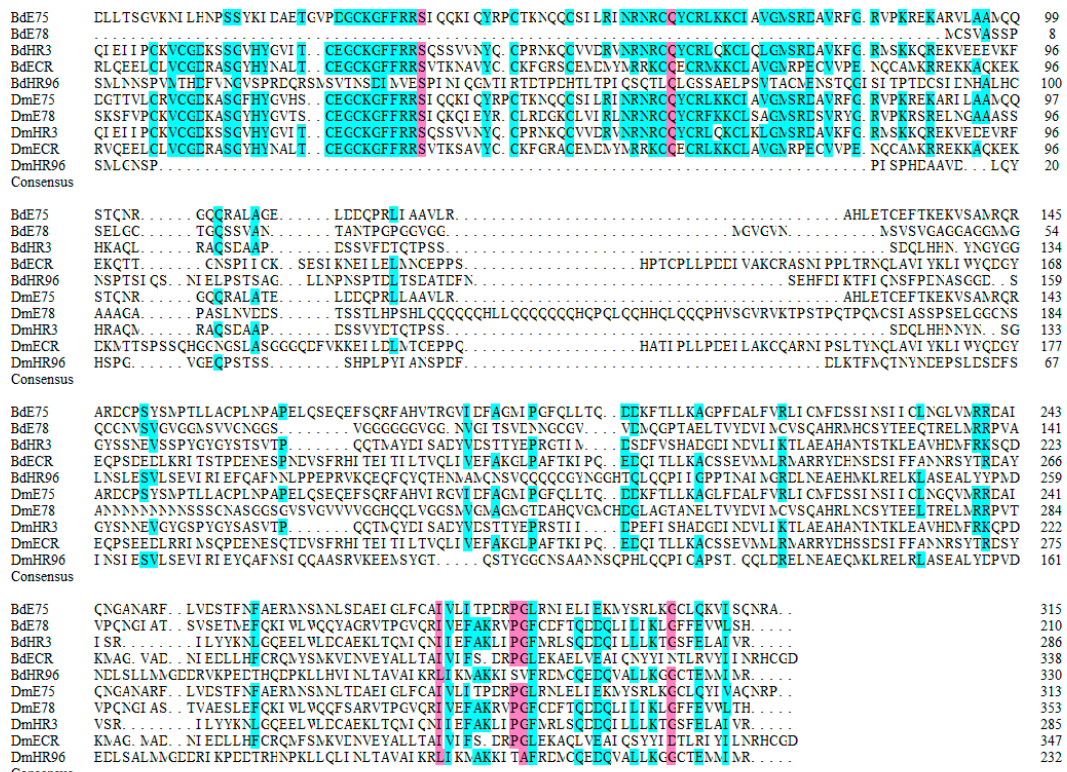
Figure 6. Conserved regions in the NR0 subfamily of B. dorsalis and D. melanogaster NR proteins. Amino acid sequences of the NR0 subfamily catalytic domains were aligned using DNAMAN 6 (https://www.lynnon.com/downloads.html). Identical and highly conserved amino acids are indicated by black (100%), pink (75%), and blue (50%), respectively.